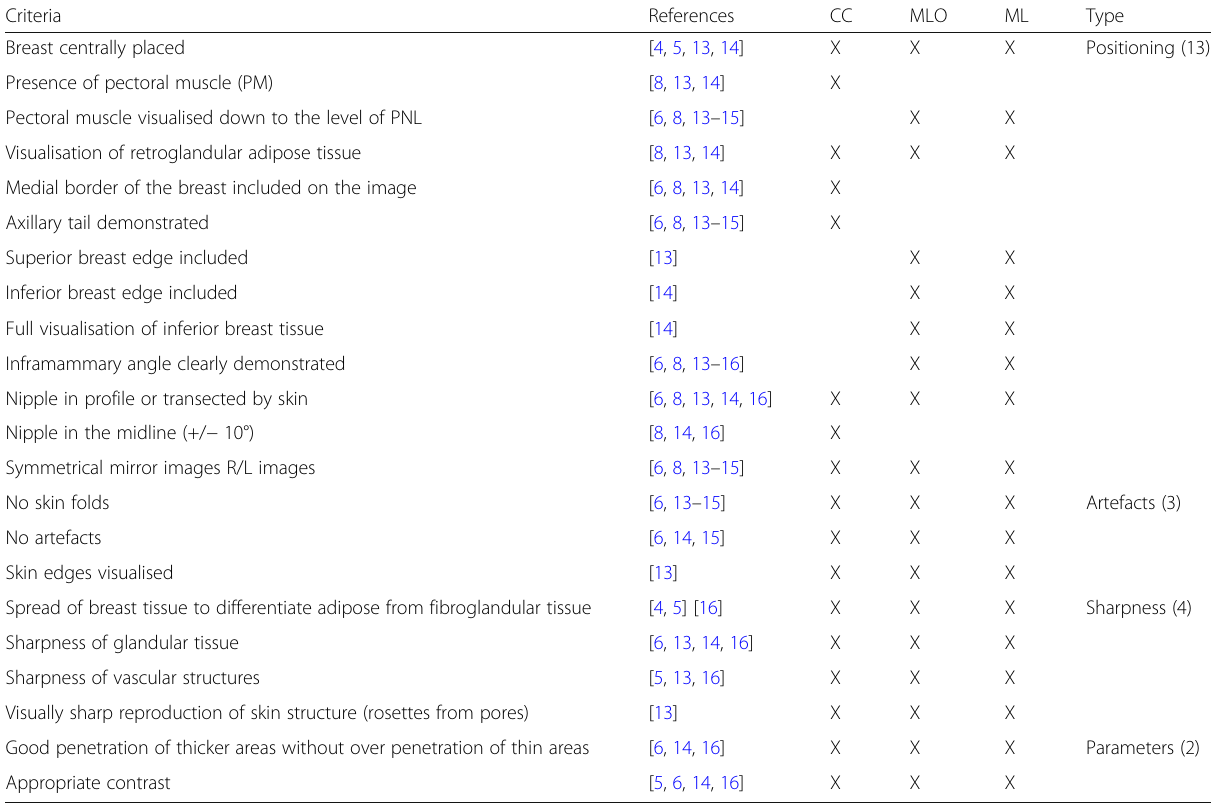
Table 1 Criteria to assess mammography examinations to be used by radiographers before sending the examination to radiologists for CC , craniocaudal; MLO , mediolateral oblique; and ML , mediolateral images